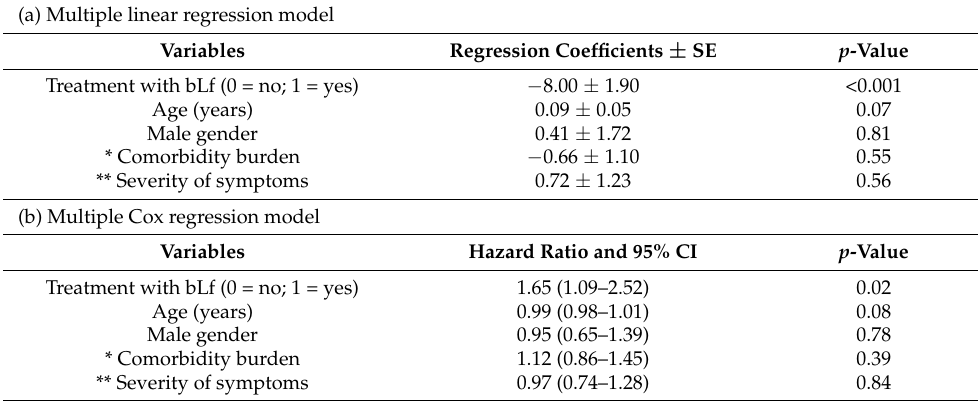
Table 2. Multiple linear regression (a) and multiple Cox regression (b) models of time to SARS-CoV-2 RNA